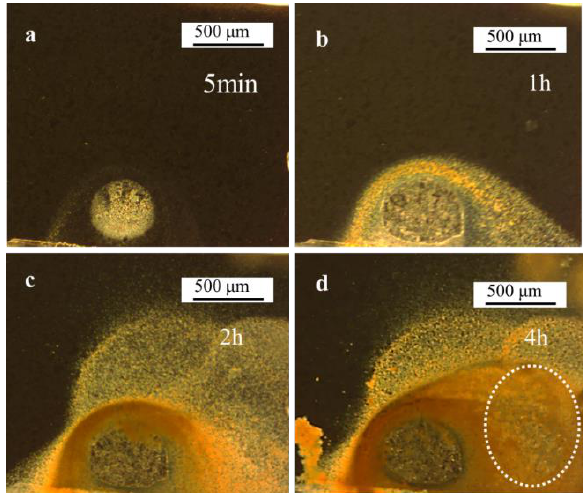
Figure 8. Optical-microscope images (left) of the experimental steel during immersion in the solution in the 4 h SVET test: ( a ) 5 min; ( b ) 1 h; ( c ) 2 h; and ( d ) 4 h.